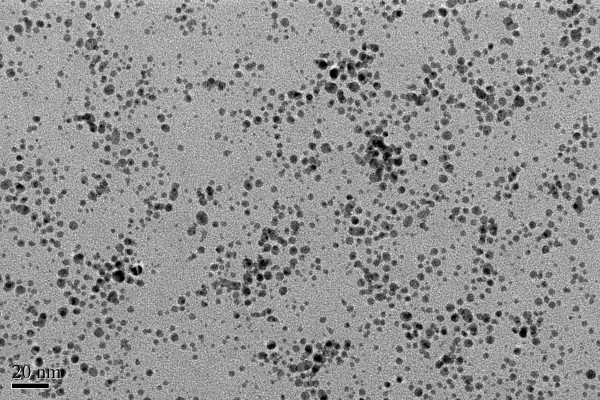
TEM images of {(Au0)200-G5.NH2} DENPs.